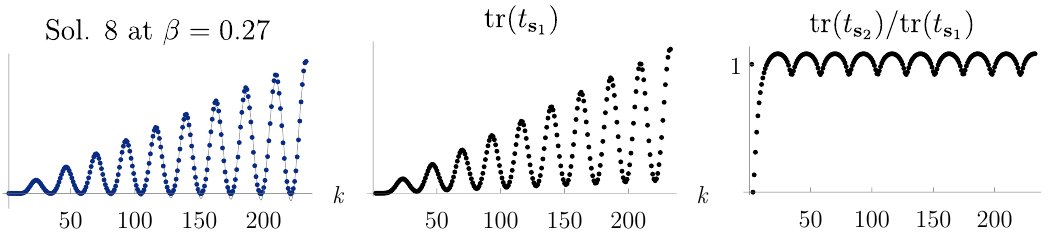
Figure 5 . The k -dependence exempli(cid:12)ed by the overlap of solution 8 at (cid:12) = : 27, to the left. It is inherited from the k -dependence of tr( t s permutations inside the trace does not matter much. The example ratio also involving tr( t s tr( t 2 t 1 t 2 t 2 t 3 t 1 ) is shown to the 3 1